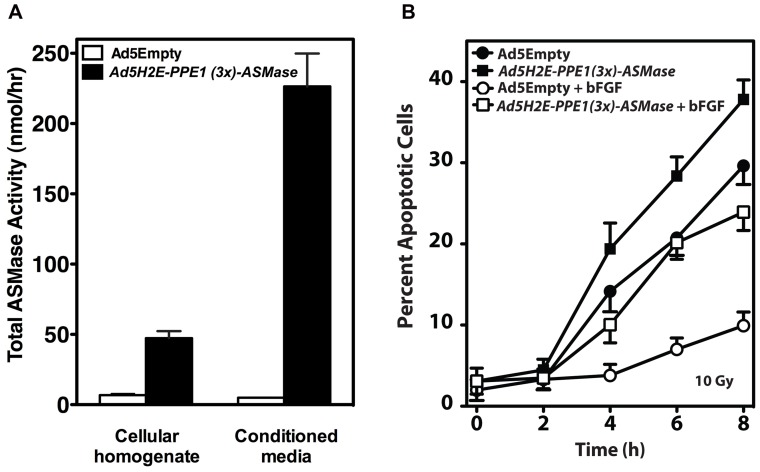
Overexpression of human ASMase via Ad5H2E-PPE1(3x)-ASMase increases lysosomal and secretory ASMase activity, radiosensitizes BAEC, and attenuates bFGF protection against radiation-induced apoptosis.(A) Cellular homogenates and serum-free conditioned media were harvested from BAEC transduced with Ad5Empty or Ad5H2E-PPE1(3x)-ASMase and assayed for ASMase activity using [14C-methylcholine]sphingomyelin as substrate in the presence of 1 mM EDTA (cellular homogenates) or 0.1 mM Zn2+ (conditioned media). (B) BAEC transduced with Ad5Empty or Ad5H2E-PPE1(3x)-ASMase were pre-treated with 1 ng/ml bFGF 15 minutes prior to 10 Gy irradiation. Apoptosis was assessed at various time points after IR by morphologic analysis following bis-benzimide staining. Data (mean ± SEM) are collated from 3 experiments performed in triplicate in which 400 nuclei were analyzed per sample.